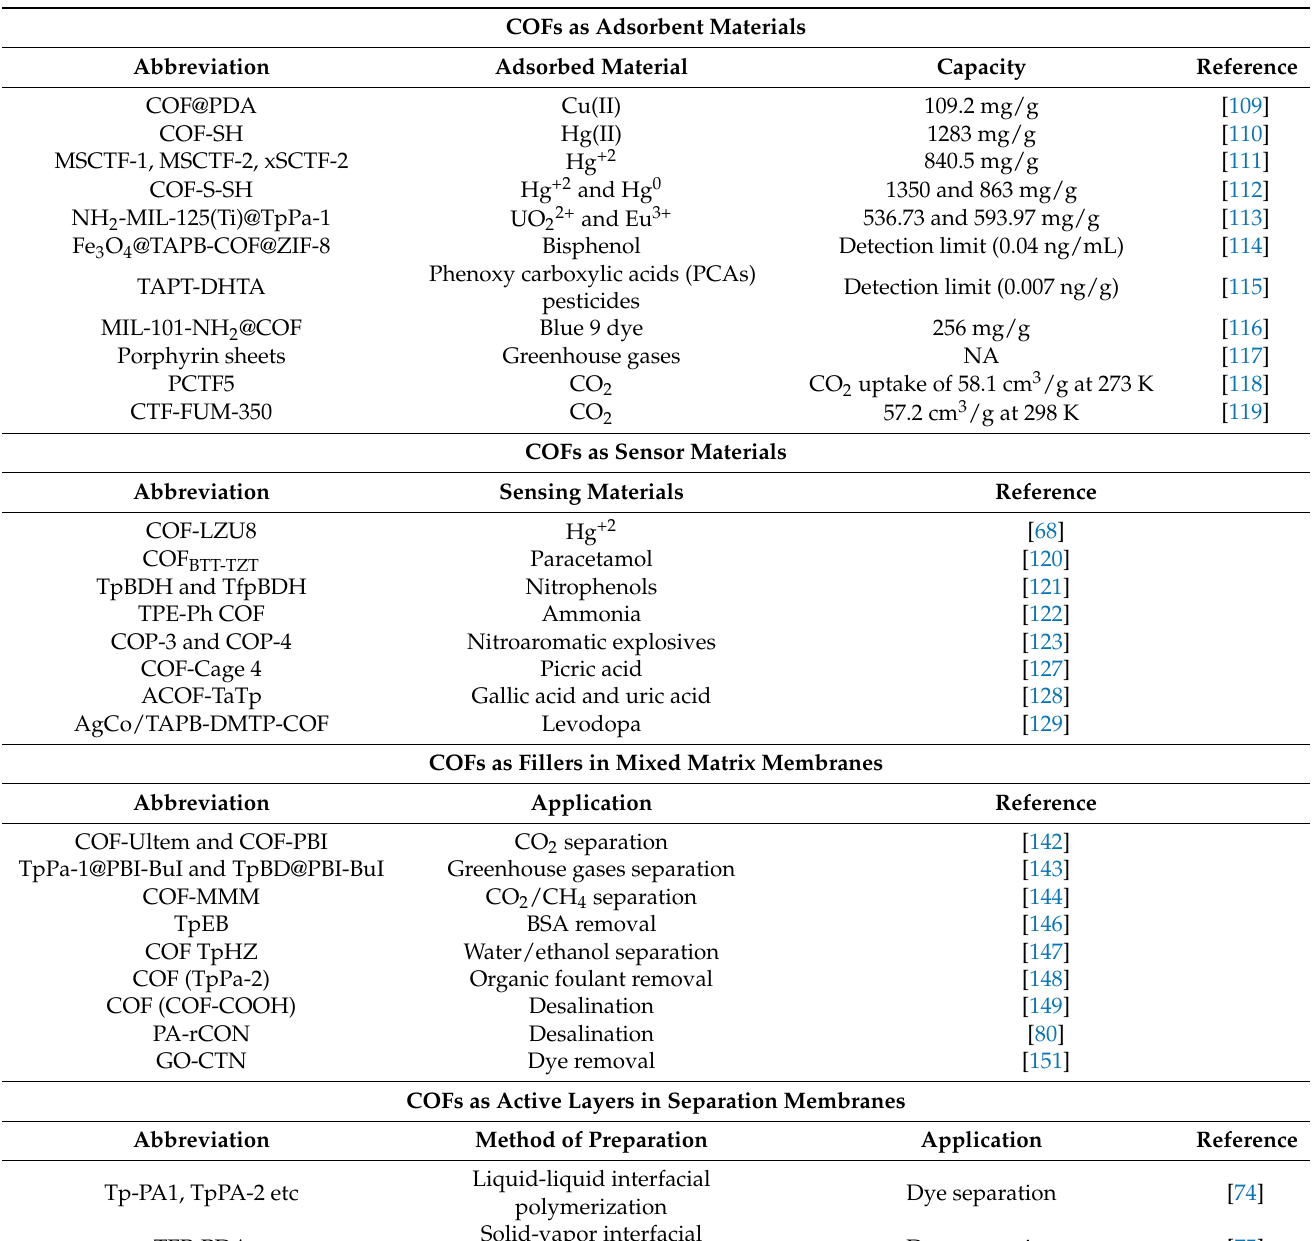
Table 1. Summary of various applications of